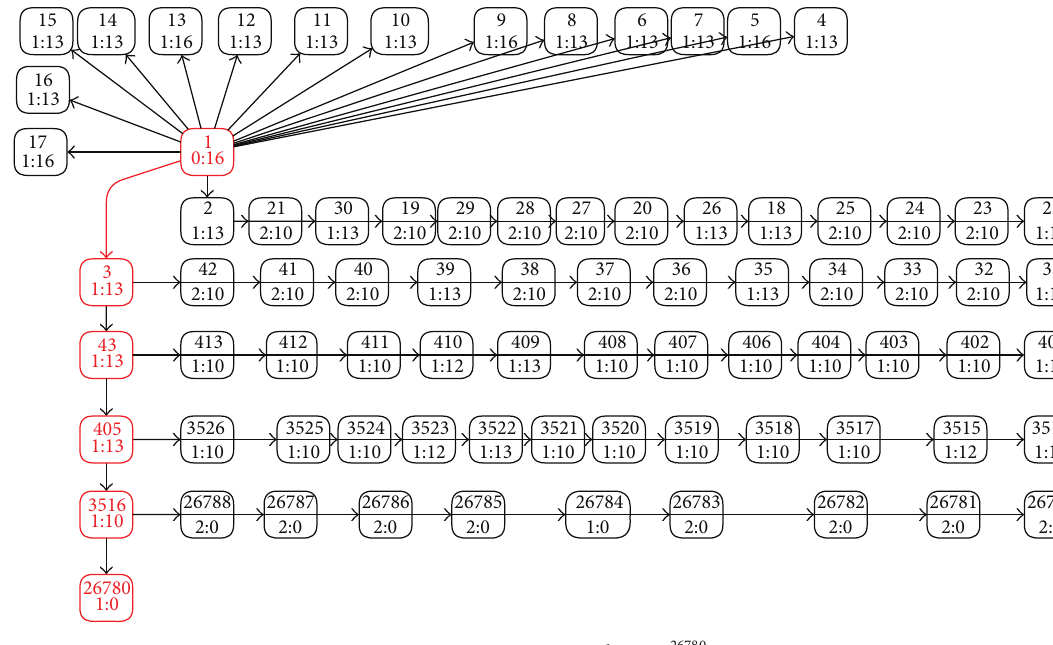
Figure 8: State space analysis, 𝑂 26780